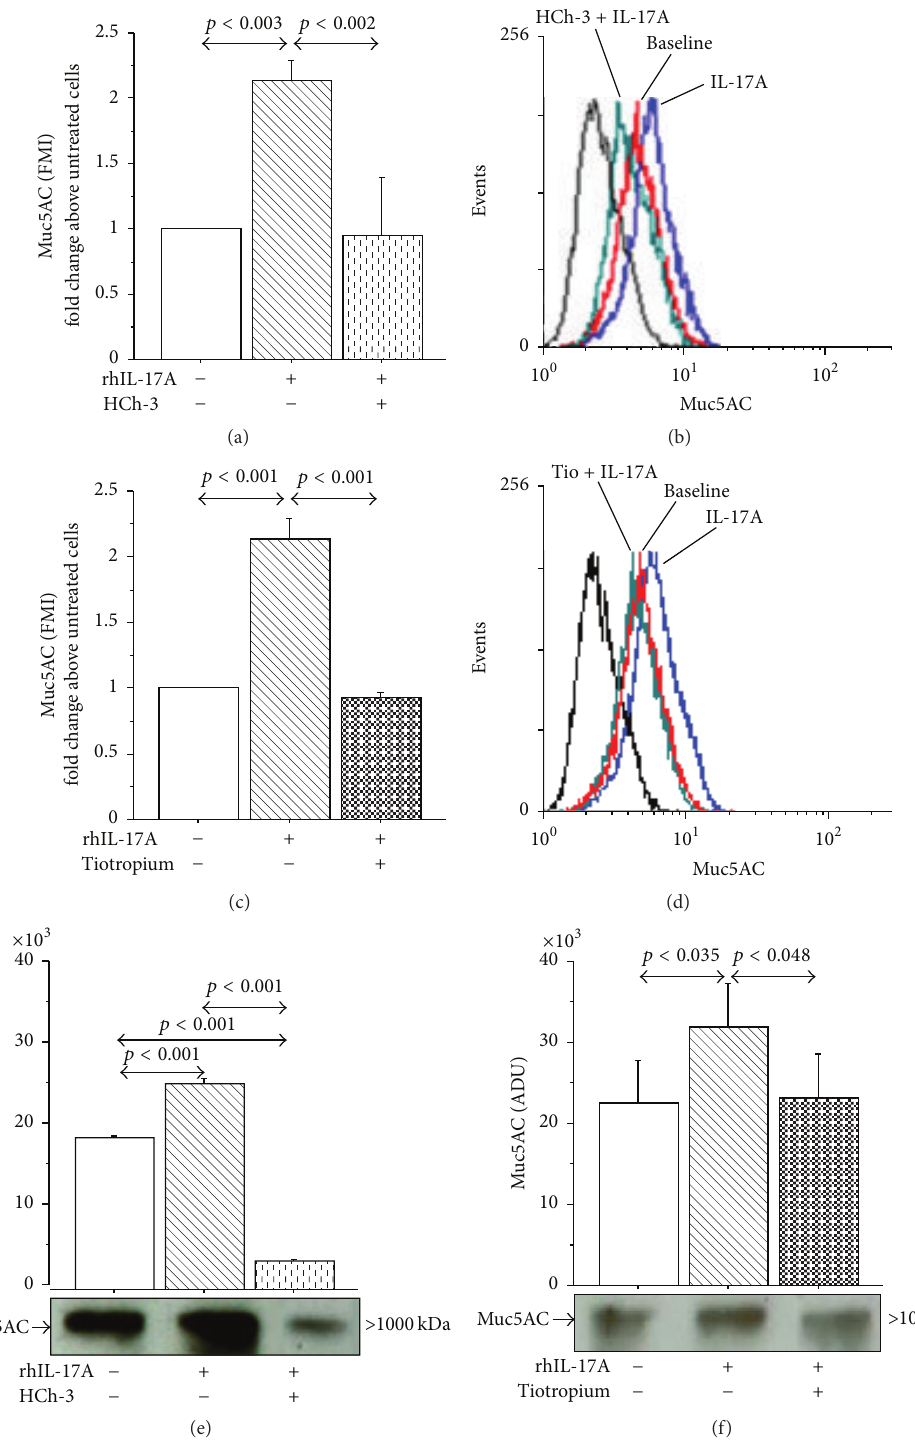
Figure 7: Effect of Hemicholinium-3 (HCh-3) or Tiotropium on Muc5AC production in 16-HBE cells. Cells were incubated for 1h with HCh-3 (50 𝜇 M) or Tiotropium (100nM) before addition of rhIL-17A 20 ng/mL for 24 h to evaluate ((a)–(d)) Muc5AC protein expression by flow cytometry. Bars represent mean ± SD of fluorescence mean intensity (FMI) of three separate experiments. Data were plotted as fold change compared to untreated cells. Representative flow cytometry of Muc5AC is shown. ((e)-(f)) Muc5AC protein expression by western blot. Bars represent mean ± SD of arbitrary densitometric units (ADU) of three different experiments. Representative western blot analysis of Muc5AC protein is shown. Statistical analysis was performed by ANOVA followed by Fisher’s PLSD multiple comparison test. The black curve represents the anti-IgG isotype negative control